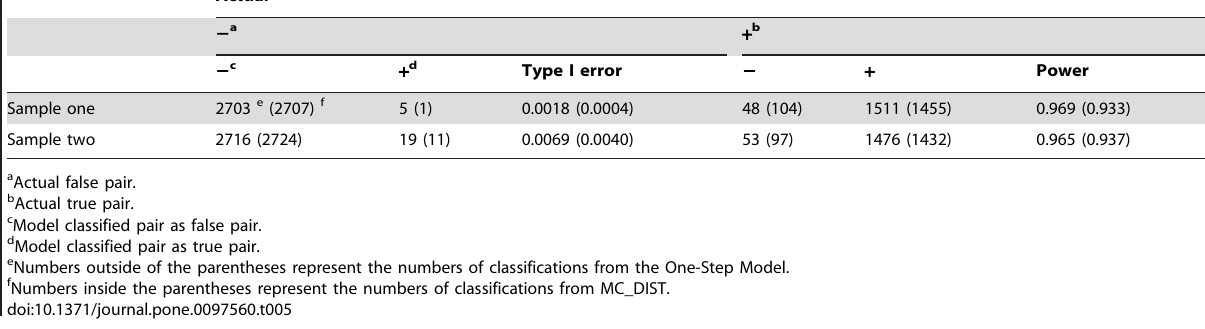
age, there are three main functions: one for MC_DIST, one for